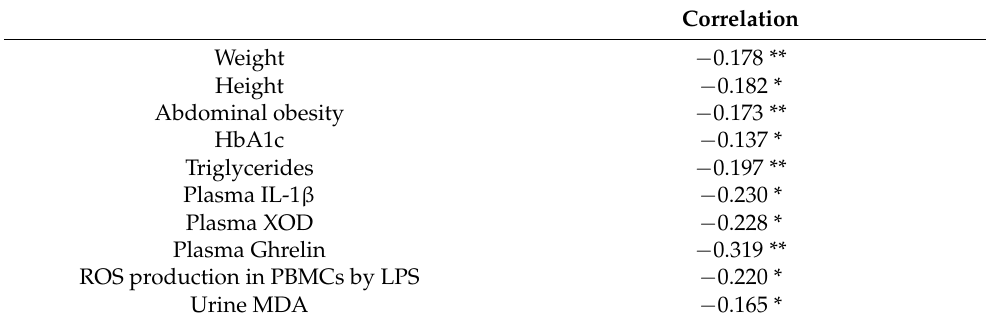
Table 5. Correlation between adherence to the Mediterranean Diet Pattern and parameters analyzed.